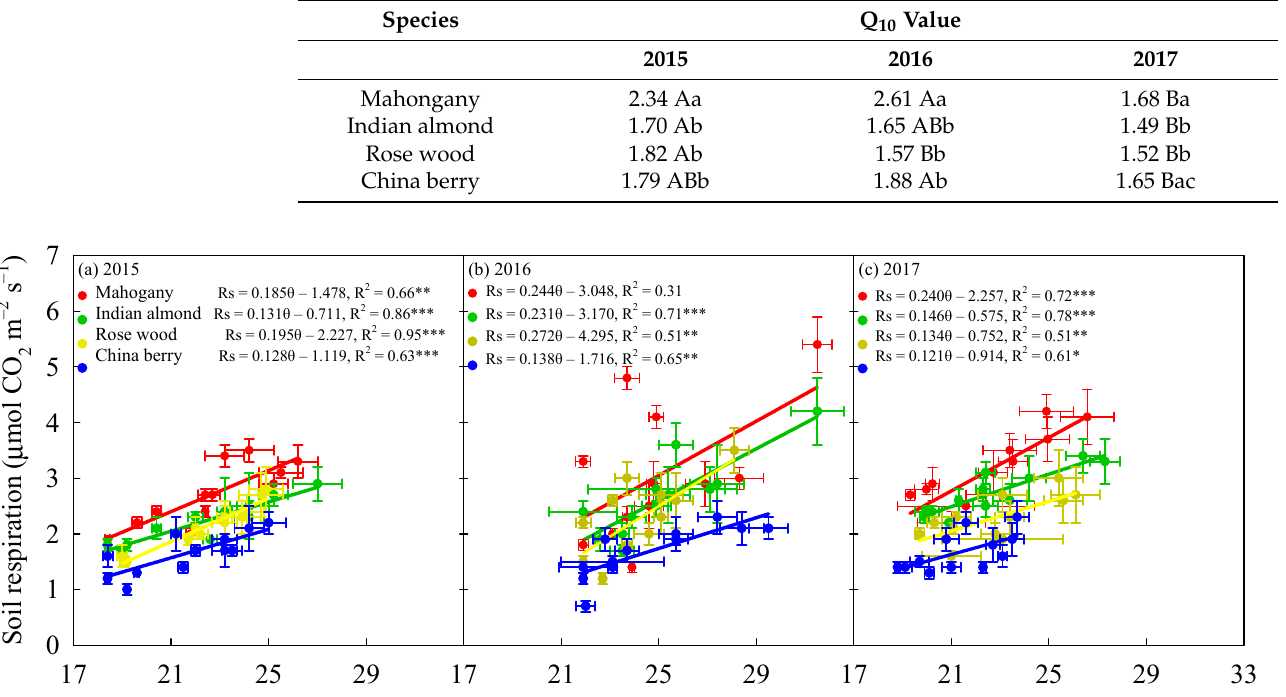
Figure 4. Relationships between monthly mean soil respiration (Rs, µ mol CO 2 m − 2 s − 1 ) and soil temperature at a 5 cm depth ( ◦ C) for studied tree species in ( a ) 2015 ( b ) 2016, and ( c ) 2017. Asterisks indicate a significance: * p < 0.05, *** p < 0.001. Values are presented as the mean ± standard errors, n = 4. Table 3. The Q 10 values ( n = 4) as a function of soil temperature ( ◦ C) at 5 cm depth from 2015 to 2017. Different capital letters indicate differences among years for the same species at p < 0.05. Different lowercase letters indicate differences among species within the same years at p < 0.05.